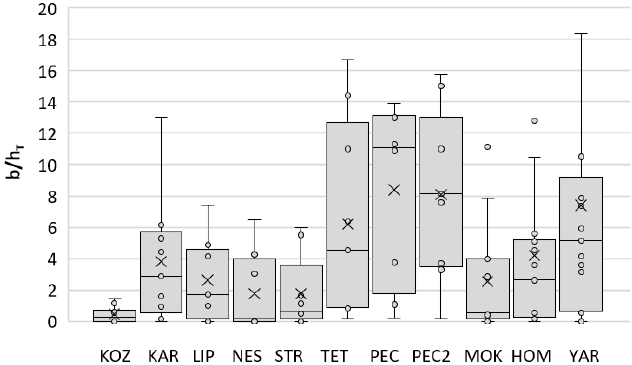
Figure 9. The variability of b/h T index (bats per hour) by different study plots; outliers for HOM — HOM—23.2, and YAR—42, not shown on the figure; “x”—average; “-”—median; dots—each night of 23.2, and YAR — 42, not shown o n the figure; “x”—average; “ - ”— median; dots — each night of mist- netting.